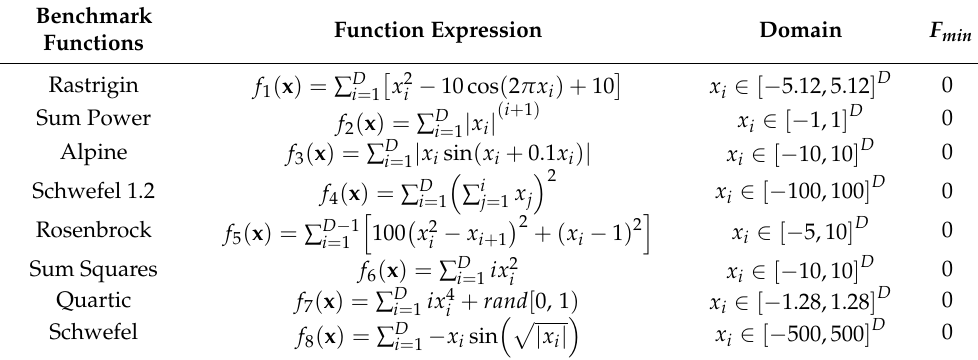
Table 1. Benchmark